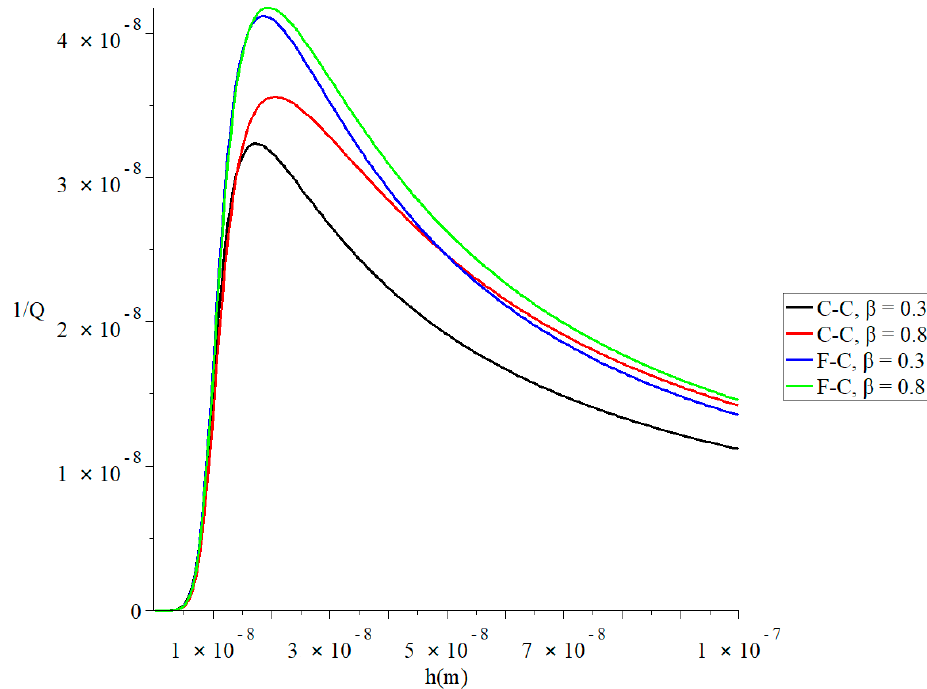
Figure 4. The thermal quality factor is based on the Lord-Shulman model with various fractional derivative types when L = 50 h , b = 4 h , q = 4.73/ L , and F = 10 − 40 .